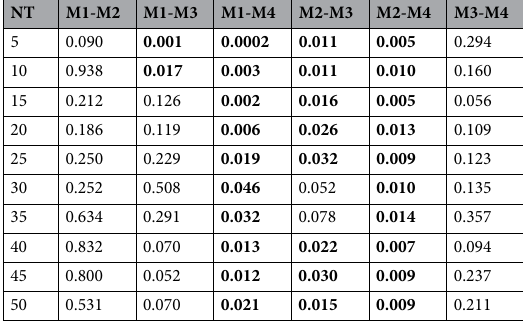
Table 2. Statistically significant differences in accuracy ( p values) among the four algorithms based on paired t-tests at the confidence level of 95%. NT: Number of training trials; M1: SSL; M2: TL-ASS; M3: TL-LEDA- ASS; M4: TL-LEDA-TSS. Significant values are in bold.